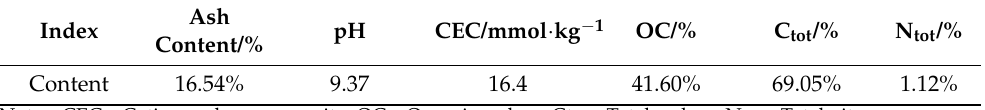
Table 2. Selected properties of tested biochar.